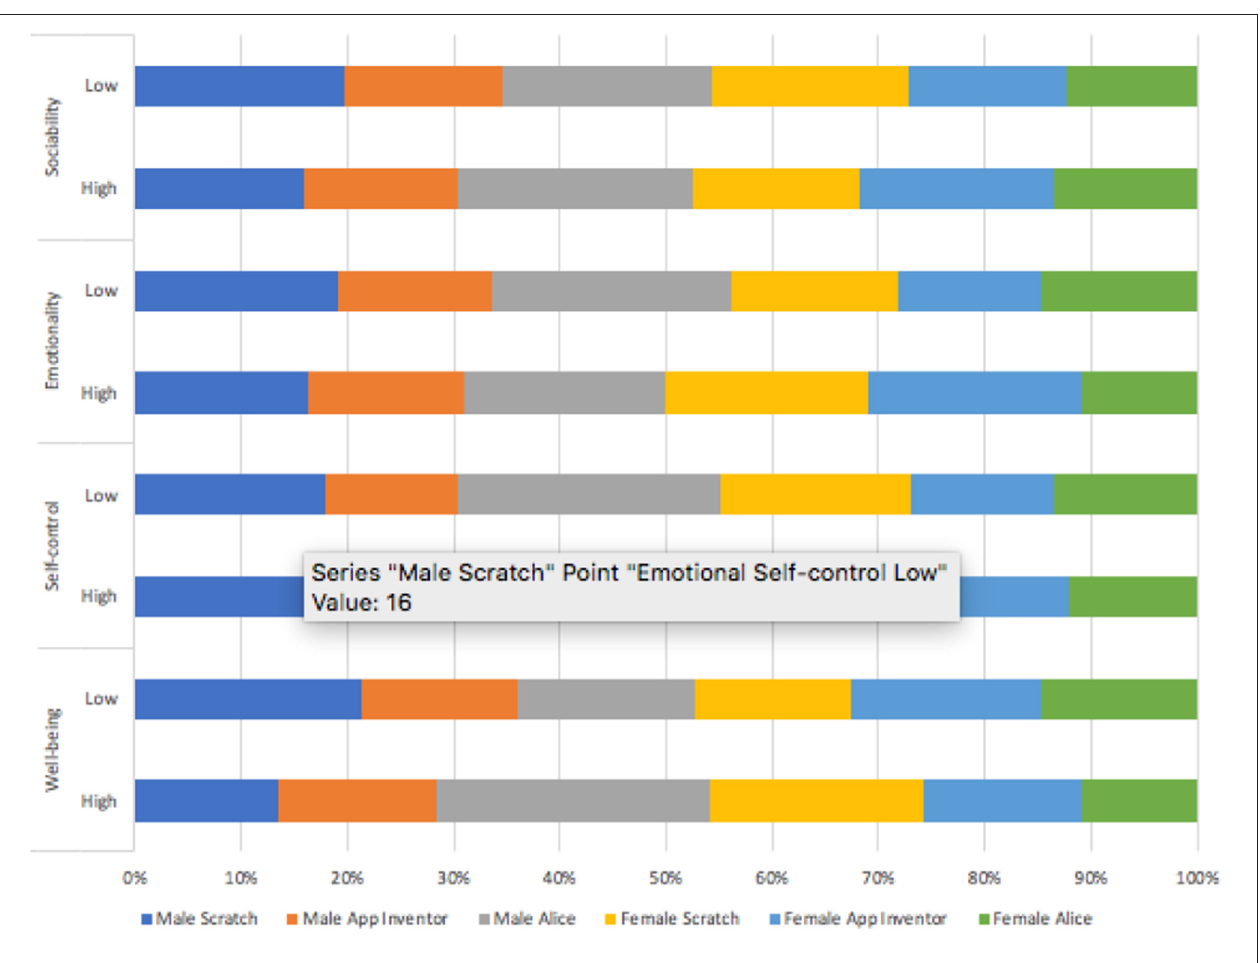
FIGURE 4 | Gender and emotional profiles (EQ) per group.